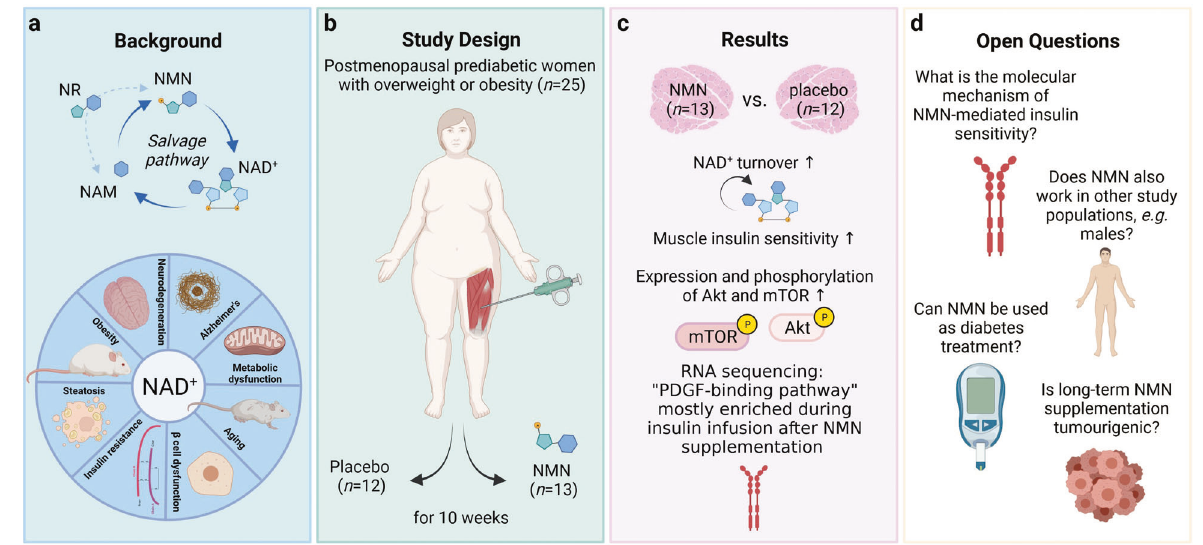
Fig. 1 a In a salvage pathway nicotinamide ribose (NR) and/or nicotinamide (NAM) are converted to nicotinamide mononucleotide (NMN), which is the precursor of nicotinamide adenine dinucleotide (NAD + ). NAD + is involved in a spectrum of diseases. b Postmenopausal prediabetic women with overweight or obesity were treated with NMN or placebo for 10 weeks and muscle biopsies revealed, c increased muscle NAD + turnover, insulin sensitivity, phosphorylation of mTOR and Akt, and a gene expression involving the PDGF-binding pathway in NMN-treated participants as compared to control. d Open questions, however, remain to fully assess the mechanism of NMN in mediating muscle insulin sensitivity. Furthermore, potential long-term side effects should be considered. The fi gure was generated with